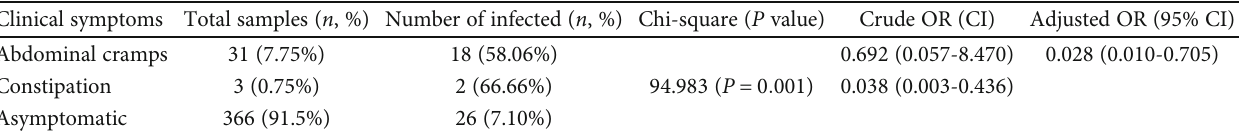
Table 6: Clinical symptoms associated with infestation of intestinal parasitic